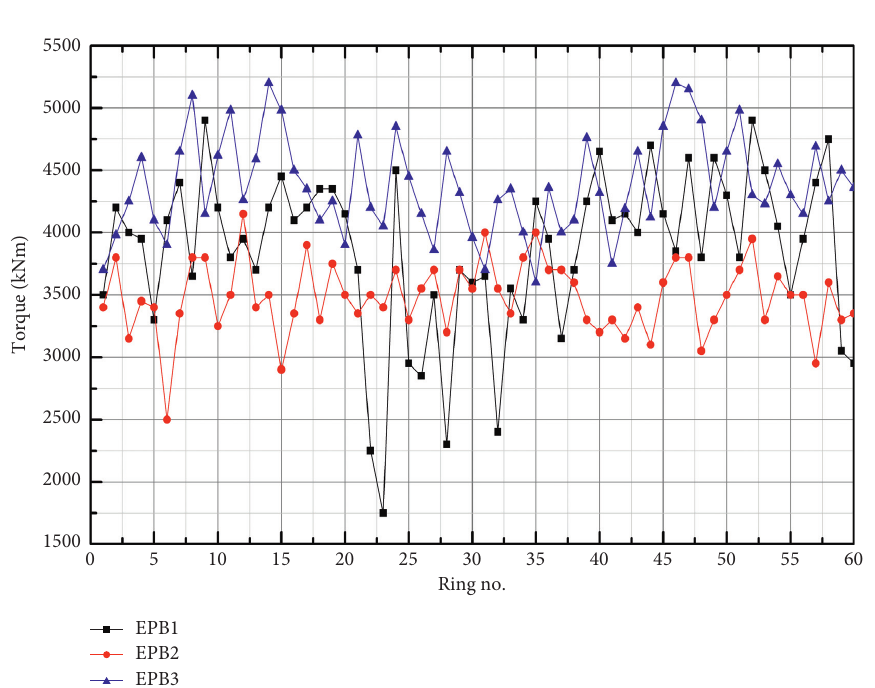
Figure 12. The maximum surface settlements that cor- respond to EPB1, EPB2, and EPB3 are 29 mm, 18 mm, and 37 mm, respectively.